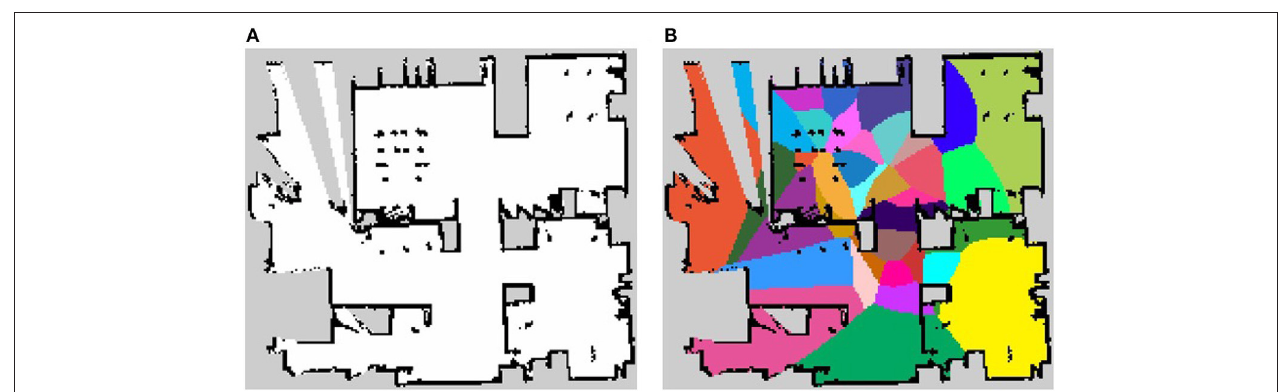
FIGURE 9 | The maps used in the experiment. (A) The occupancy grid map of personal living environment and (B) the result of pre-learning.